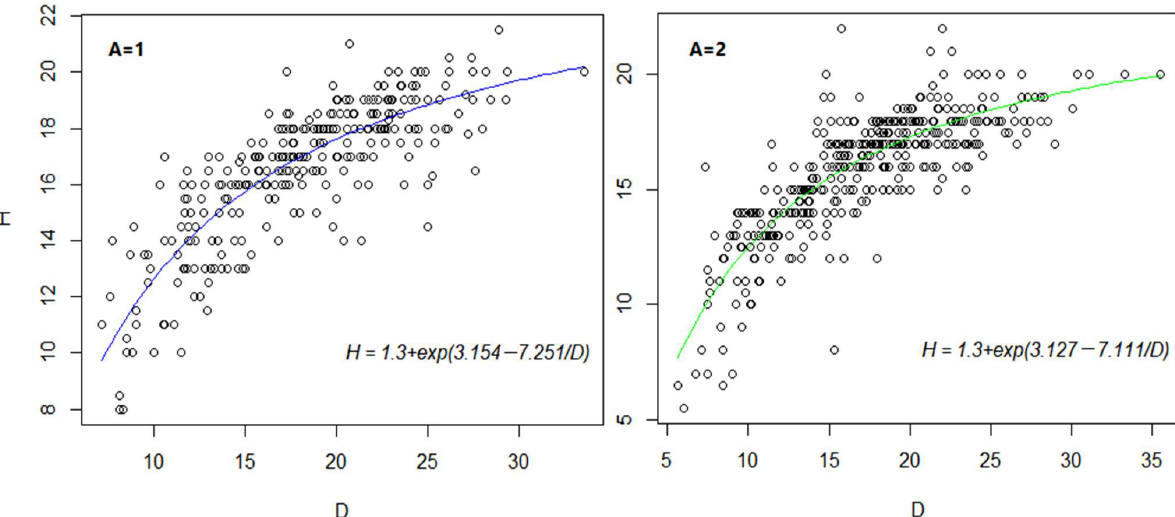
Figure 6. The fitting curves of height-diameter relationship at different altitude levels. The left plot is the fitting curve of height-diameter relationship of 300 observations at altitude higher than 700 m (A = 1). The right is the fitting curve of height-diameter relationship of 465 observations at altitude less than 700 m (A = 2). H= tree height (m); D = diameter at breast height (cm).